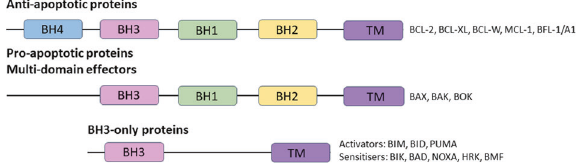
Fig. 2 The structure of BCL-2 protein family members. TM denotes the transmembrane